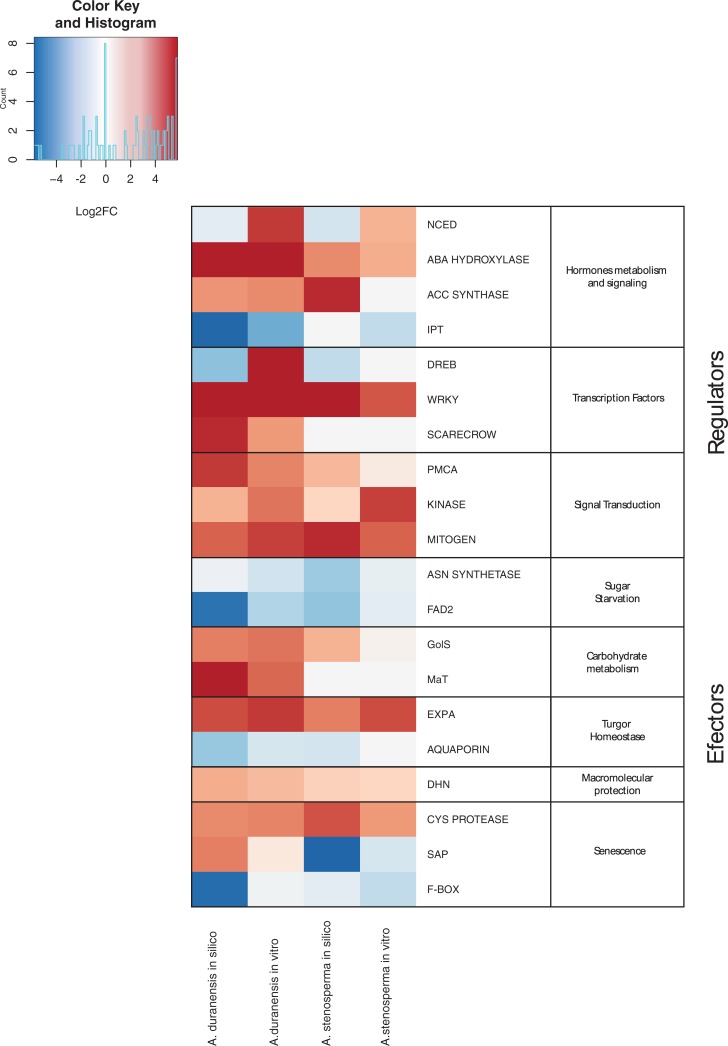
Heatmap of the relative expression of the 20 candidate genes in Arachis duranensis and A. stenosperma after in silico (RNA-Seq data) and in vitro (qRT-PCR) analyses.Normalized log2FC values are shown in a red–blue scale, with darker red the most upregulated and the darker blue the most downregulated DEGs.